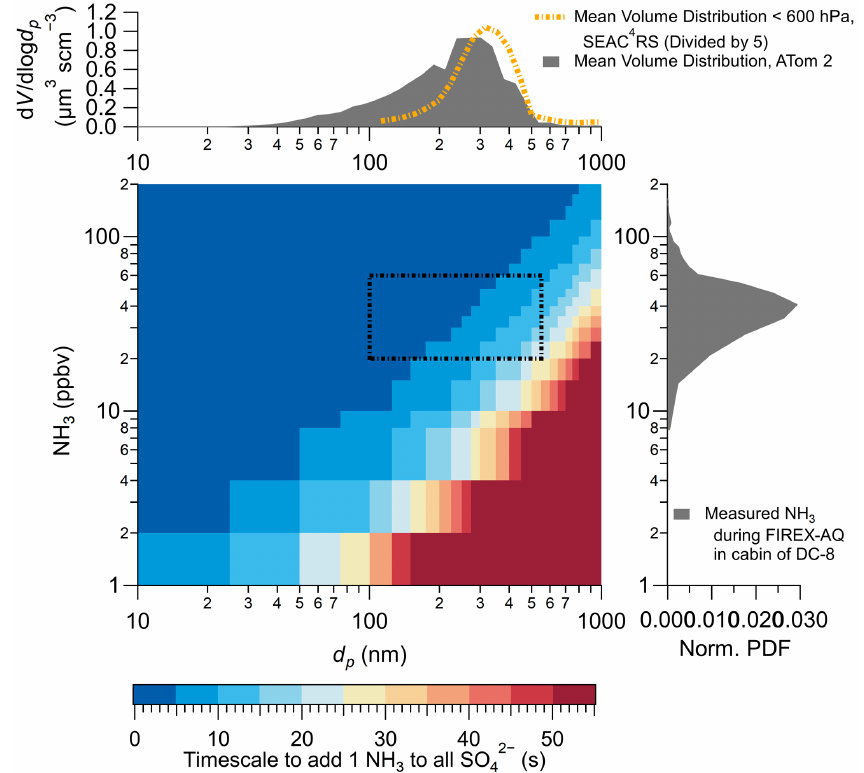
Figure 7. Theoretical calculation for the amount of time it would take for all the sulfuric acid on the filter to react with one ammonia molecule to become ammonium bisulfate. The volume distribution is the average from SEAC 4 RS and ATom-2 (adapted from Guo et al., 2020), and the normalized probability distribution function (norm. PDF) is from Fig. 6. The representative diameter and ammonia mixing ratio are shown as dashed lines in the calculated